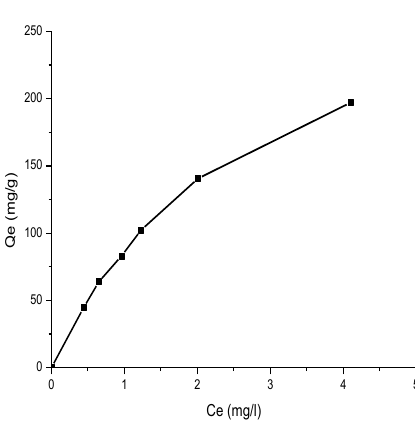
Figure 4. Amount of copper removed by Brushite (DCPD) vs. equilibrium concentration of Cu(II).